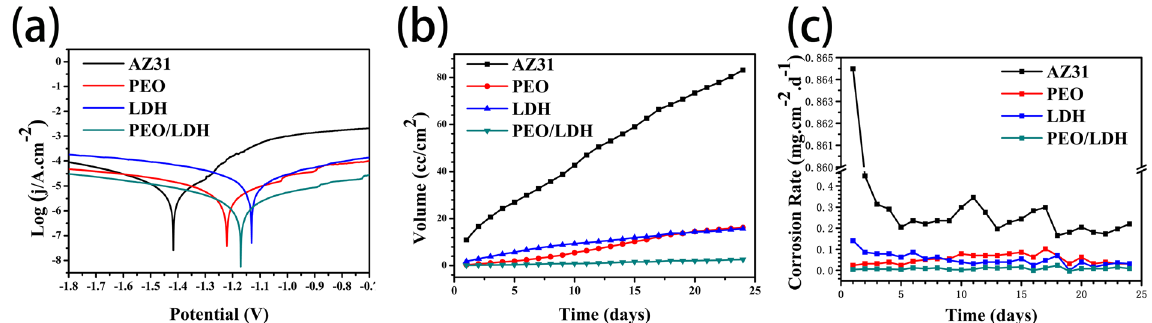
Figure 6. Polarization curves ( a ), hydrogen evolution ( b ) and corrosion rate ( c ) of all samples.